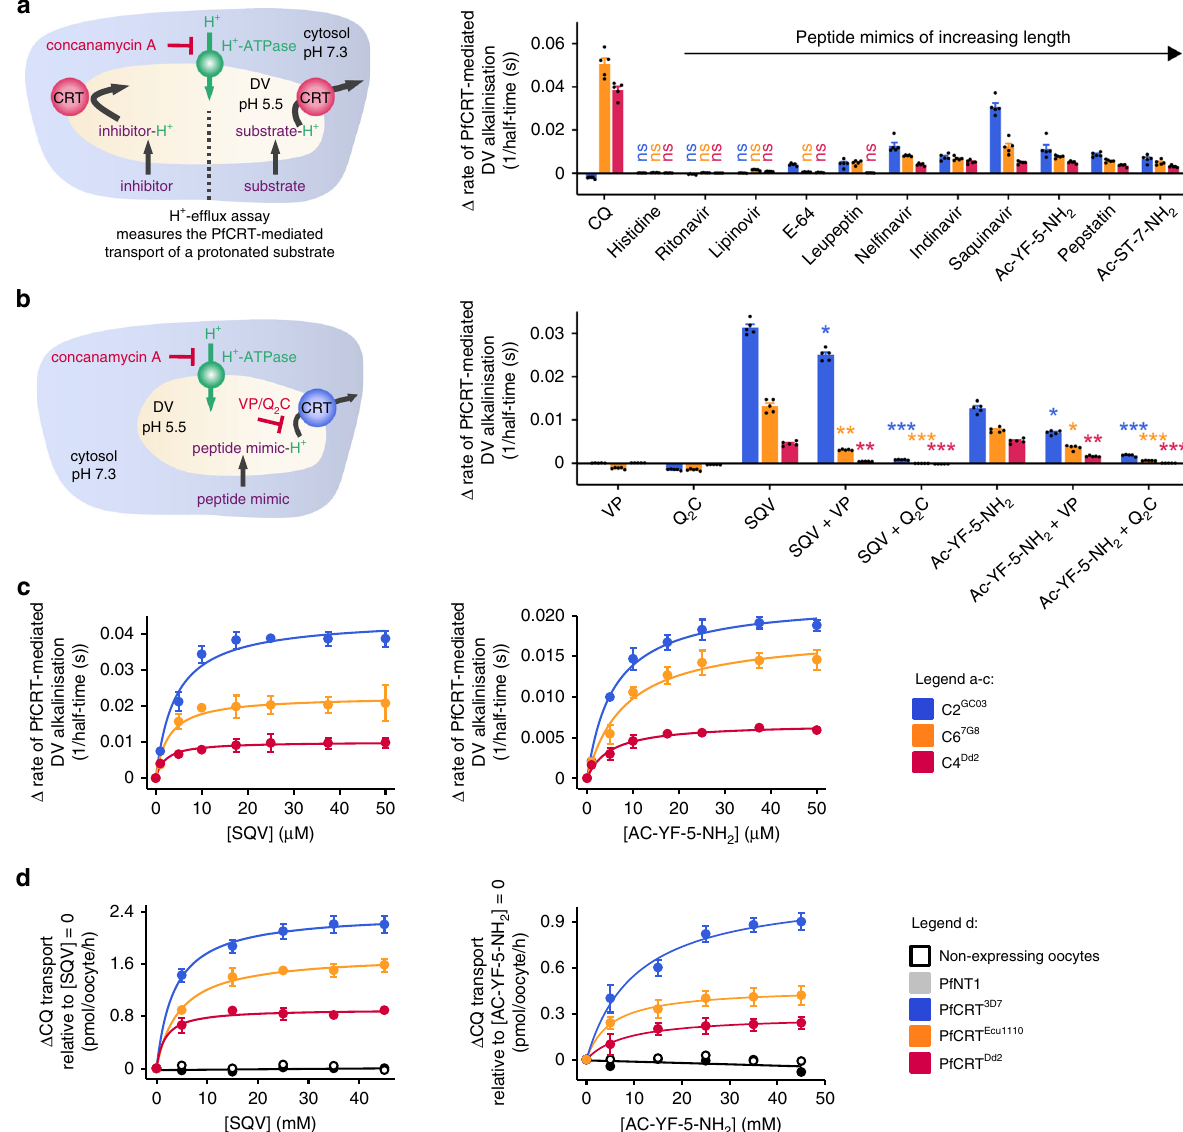
Fig. 5 Peptide mimics are substrates of PfCRT in situ. a Left: schematic showing the H + -ef fl ux assay. If a protonated solute is a substrate of PfCRT it will cause a H + leak when ef fl uxed from the DV. Inhibition of the DV ’ s H + -ATPase by concanamycin A enables this H + leak to be detected (with a pH-sensitive probe) as an increase in the rate of DV alkalinisation. Right: several peptide mimics (10 μ M) increase the rate of DV alkalinisation in C2 GC03 , C6 7G8 and C4 Dd2 parasites. CQ (the positive control) causes the rate of DV alkalinisation to increase in the C6 7G8 and C4 Dd2 lines and to decrease slightly in C2 GC03 parasites. This is consistent with previous applications of the H + -ef fl ux assay 36,37 and with the abilities of PfCRT Ecu1110 , PfCRT 7G8 and PfCRT Dd2 (but not PfCRT 3D7 ) to transport CQ when tested under normal conditions in the oocyte system 15,16 . Unless labelled ns, P < 0.05 relative to the absence of a test solute. b Left: schematic showing the inhibition of PfCRT by verapamil (VP) or the quinine dimer Q 2 C in the H + -ef fl ux assay. Right: the increase in the rate of DV alkalinisation caused by saquinavir (SQV; 10 μ M) and Ac-YF-5-NH 2 (10 μ M) is inhibited by VP (50 μ M) and Q 2 C (1 μ M). The statistical analyses were performed relative to the SQV or Ac-YF-5-NH 2 controls. c SQV (left) and Ac-YF-5-NH 2 (right) increase the rate of DV alkalinisation in a concentration-dependent manner. d Concentration-dependence of the trans -stimulation of [ 3 H]CQ transport via PfCRT by SQV (left) and Ac-YF-5-NH 2 (right) in Xenopus oocytes. The non-expressing oocyte data overlays the data obtained with oocytes expressing PfNT1. The data are the mean of n = 5 independent experiments (each yielding similar results and overlaid as individual data points in a and b ), and the error is the SEM. Where not visible, the error bars fall within the symbols. The asterisks denote a signi fi cant difference from the relevant C4 Dd2 (red asterisks), C6 7G8 (orange asterisks) or C2 GC03 (blue asterisks) control; * P < 0.05, ** P < 0.01, *** P < 0.001, ns: non-signi fi cant (one-way ANOVA). The source datasets are provided as a Source Data fi